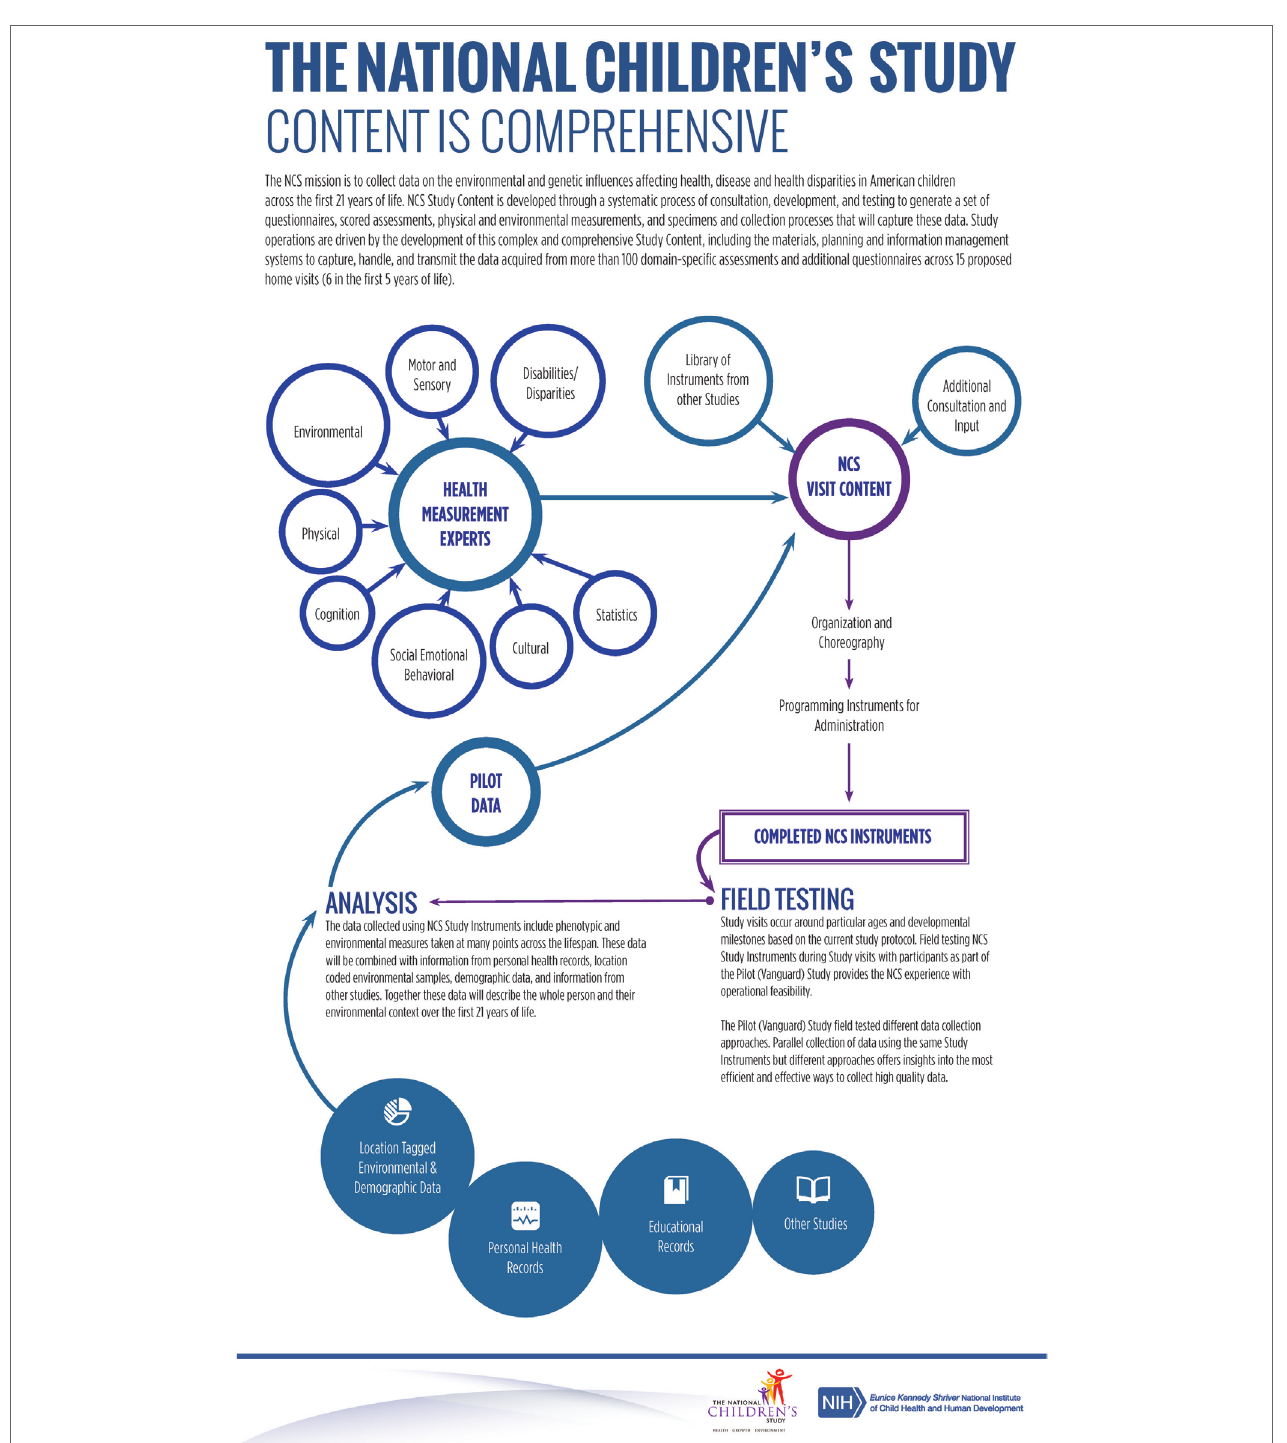
FiGURe 3 | NCS Content Development process. The proposed relations hips and workflow process to integrate material from multiple sources into an integrated